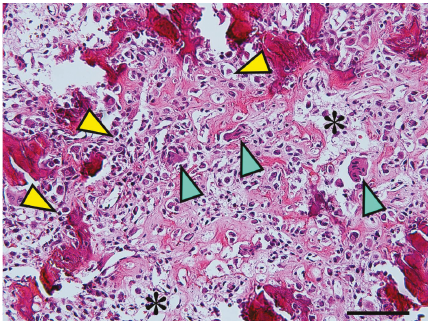
Figure 5: Histologic fi ndings. Incompletely mineralized trabeculae rimmed by scattered osteoclasts (blue arrowhead) and irregularly shaped osteoblasts (yellow arrowhead). The intervening stroma (asterisk) is loose and fi brovascular (Hematoxylin-Eosin stain, bar represents 100 μ